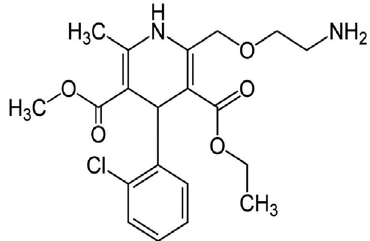
FIGURE 1 – Chemical structure of